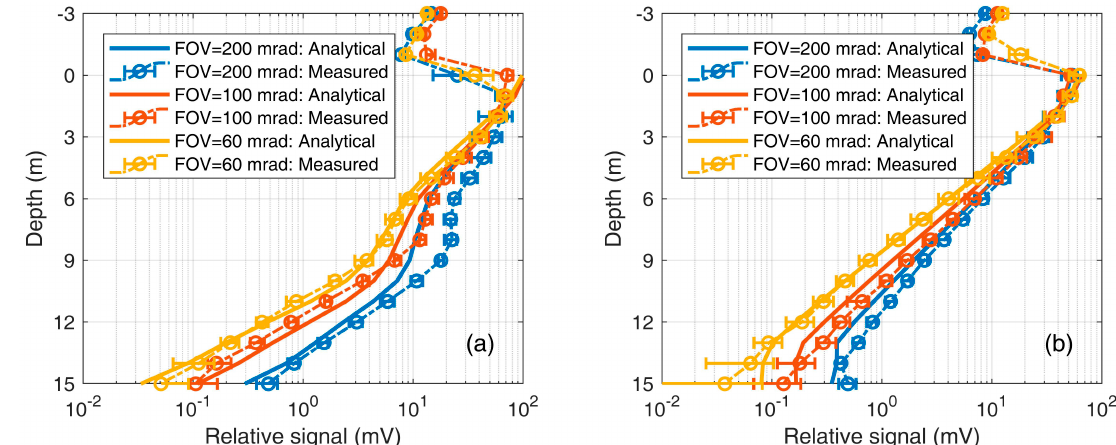
Figure 7. Lidar signals with multiple FOVs calculated by the analytical model (solid lines) and measured by the lidar (dashed–dotted lines with circles and error bars) at ( a ) Station 4 and ( b ) Station 5. Table 6. The R 2 and δ of the analytical model to lidar measurement with different FOVs at Stations 4–5.